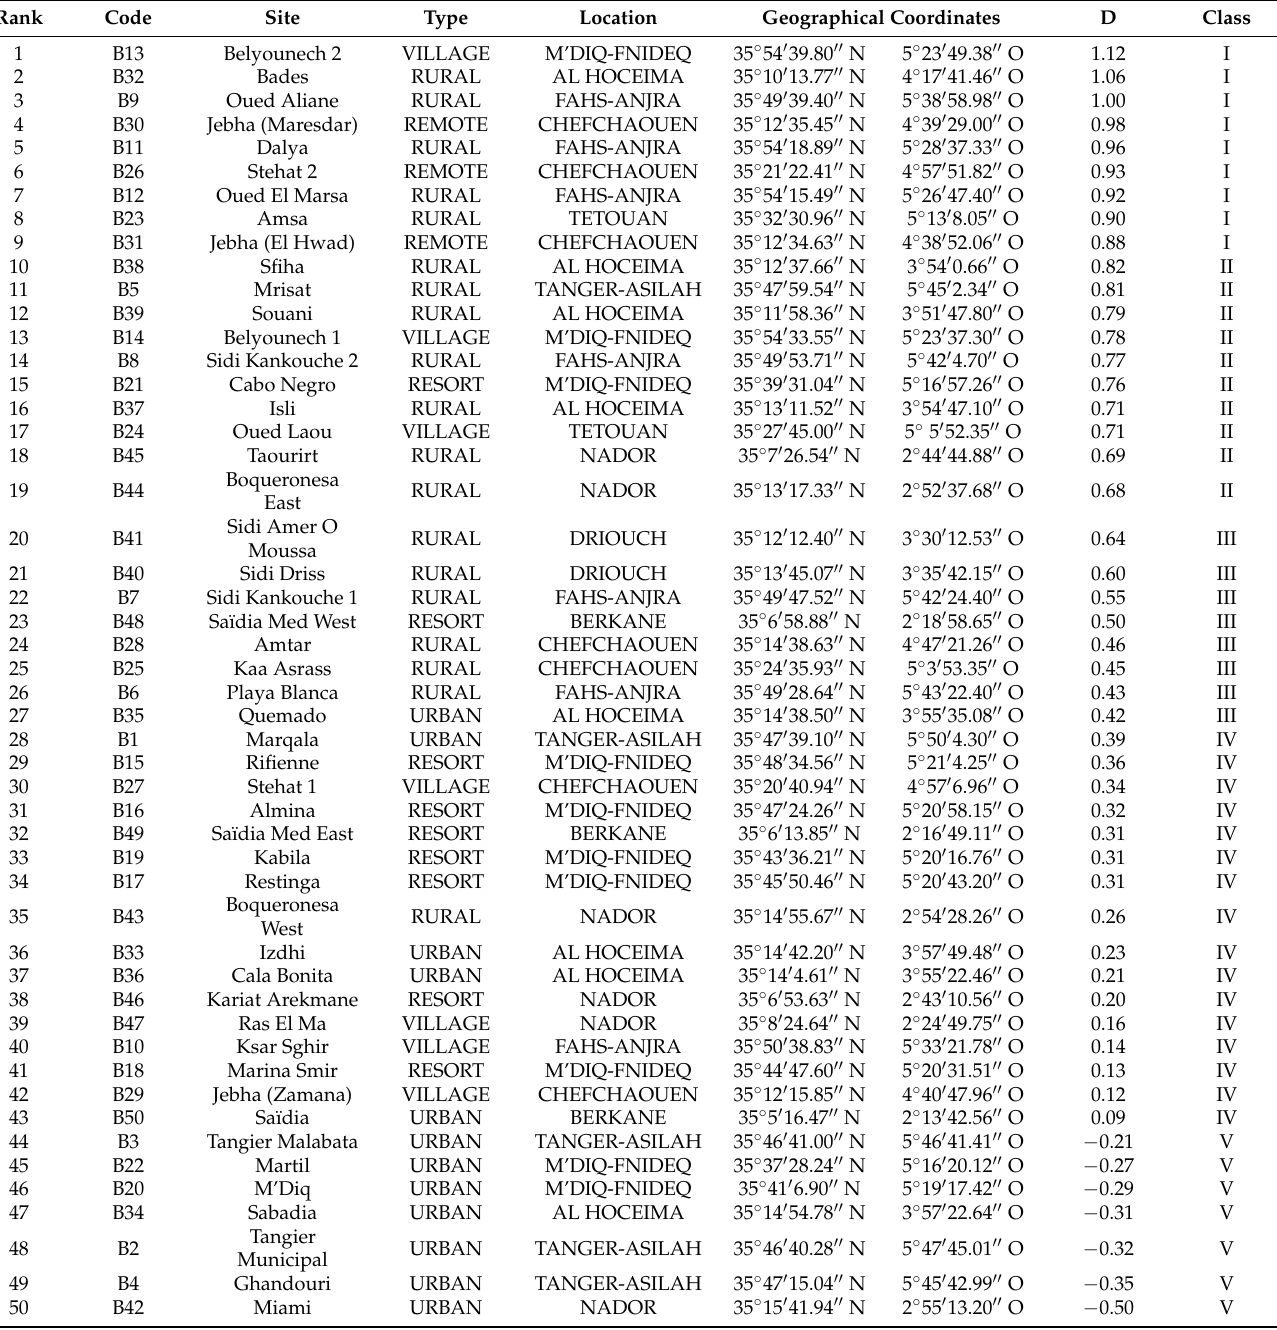
(Figure 5A), membership degree of attributes (Figure 5B), and weighted average of at- tributes (Figure 5C) and according to beach typology (Figure 5D). Histograms give a clear idea of the state of natural and human parameters of a site, and allow an instant assess- ment of attributes between high or low values, while the weight averages of the attributes delineated the relative comparison of the natural and human parameters [34,37,49]. Table 2. Location and main characteristics of the investigated sites along the Moroccan Mediterranean